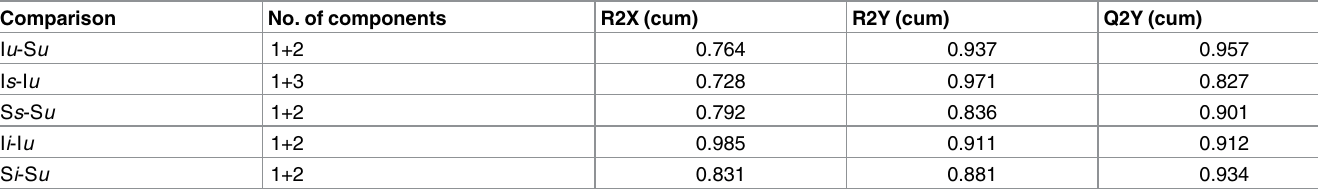
Table 1. Summaryof parameters for assessingmodel